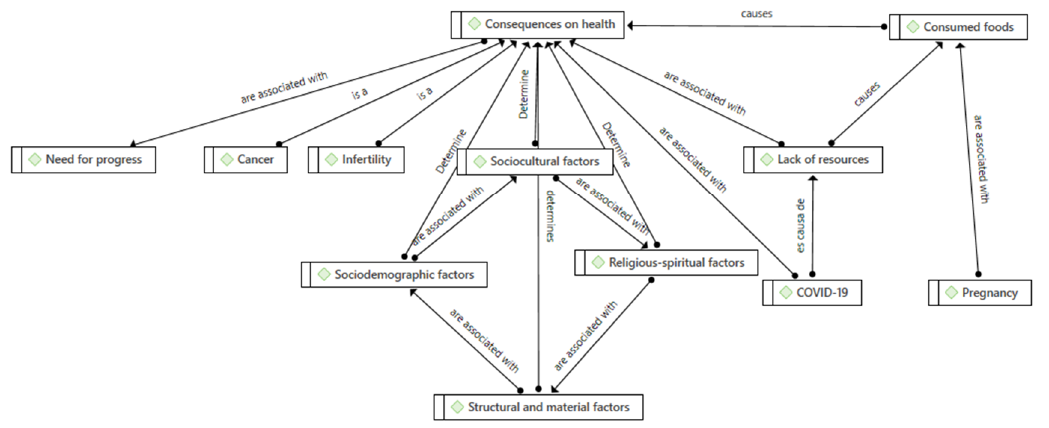
Figure 2. Gender-related health consequences and lack of resources. Source: Prepared by the authors. Table 6. Differences and consequences on health and the COVID-19 pandemic: Senegalese and Moroccan women’s statements.